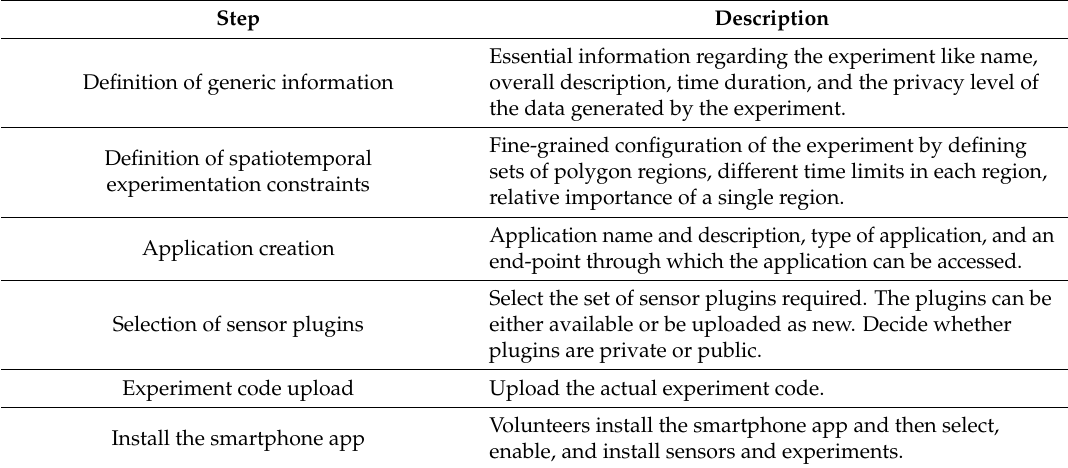
Table 1. Overview of the configuration and setup steps for